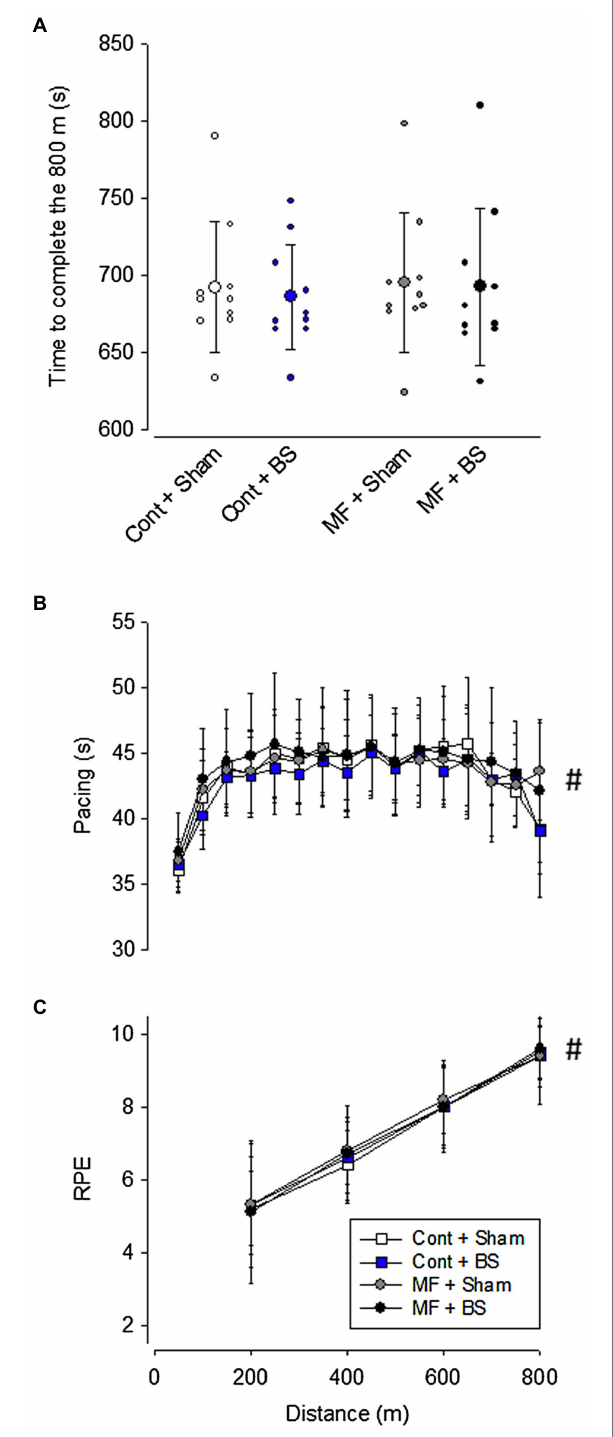
FIGURE 4 | Time to complete the 800 m of swimming (A) . Data are expressed as mean ± standard deviation, and the scattered dots represent the individual data. Pacing strategy (B) and subjective rating of perceived exertion (C) of the participants throughout the swimming trial. Data are expressed as mean ± standard deviation. # means a significant main effect of distance ( p <